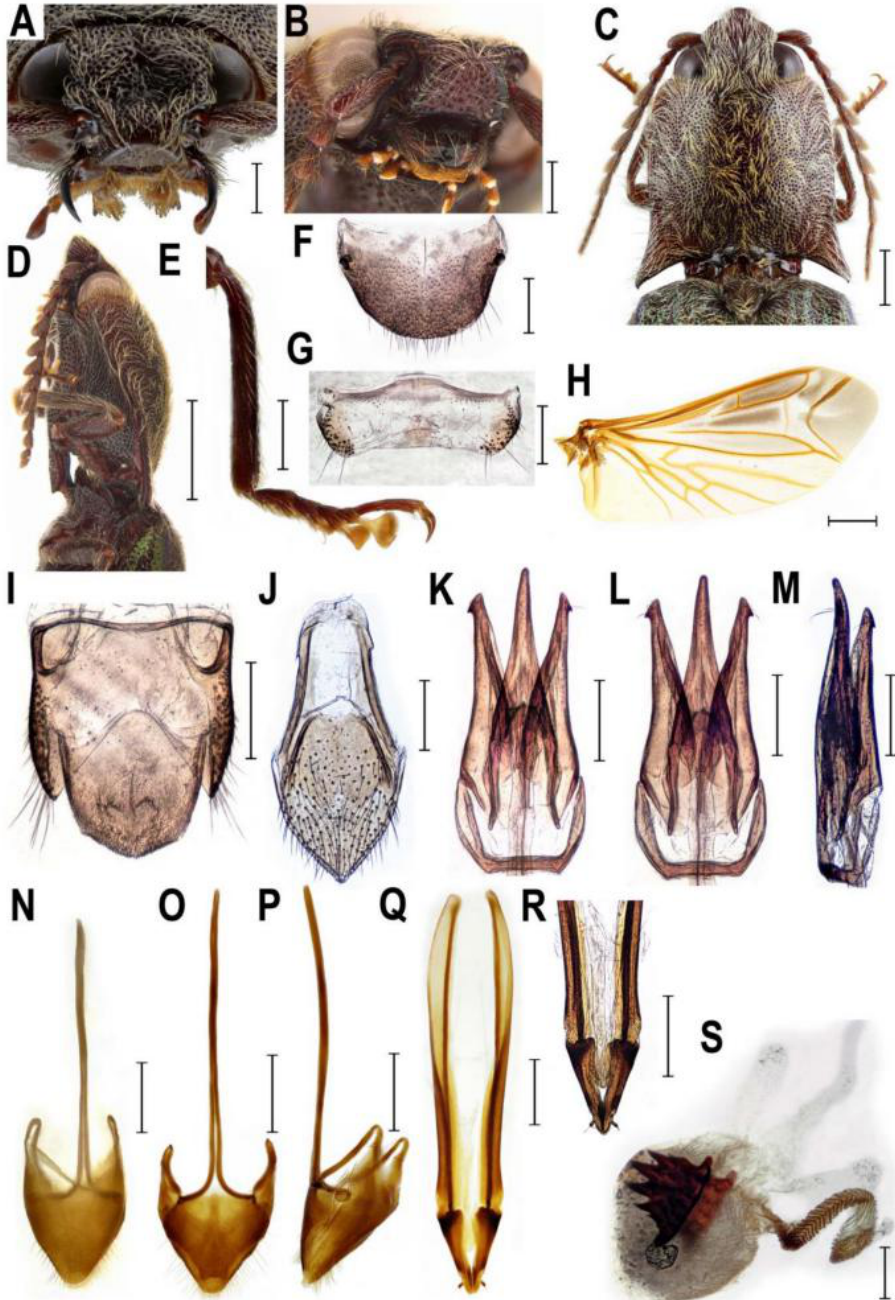
Figure 4. Morphology of Sossor hageni , Indonesia, female ( A , N – S ), male ( B – M ). ( A ) head, frontal view; ( B ) head, frontoventral view; ( C ) pronotum, dorsal view; ( D ) prosternum, lateral view; ( E ) right metatibia and metatarsus; ( F ) male abdominal tergite VIII; ( G ) male abdominal sternite VIII; ( H ) hind wing; ( I ) male abdominal tergites IX–X; ( J ) male abdominal sternite IX; ( K ) aedeagus, dorsal view; ( L ) aedeagus, ventral view; ( M ) aedeagus, lateral view; ( N ) female abdominal sternite VIII, dorsal view; ( O ) female abdominal sternite VIII, ventral view; ( P ) female abdominal sternite VIII, lateral view; ( Q ) ovipositor; ( R ) apical part of ovipositor; ( S ) bursa copulatrix. Scale bars = ( D , H ): 2 mm; ( C , N – R ): 1 mm; ( A – B , E – G , I – M ); S: 0.5